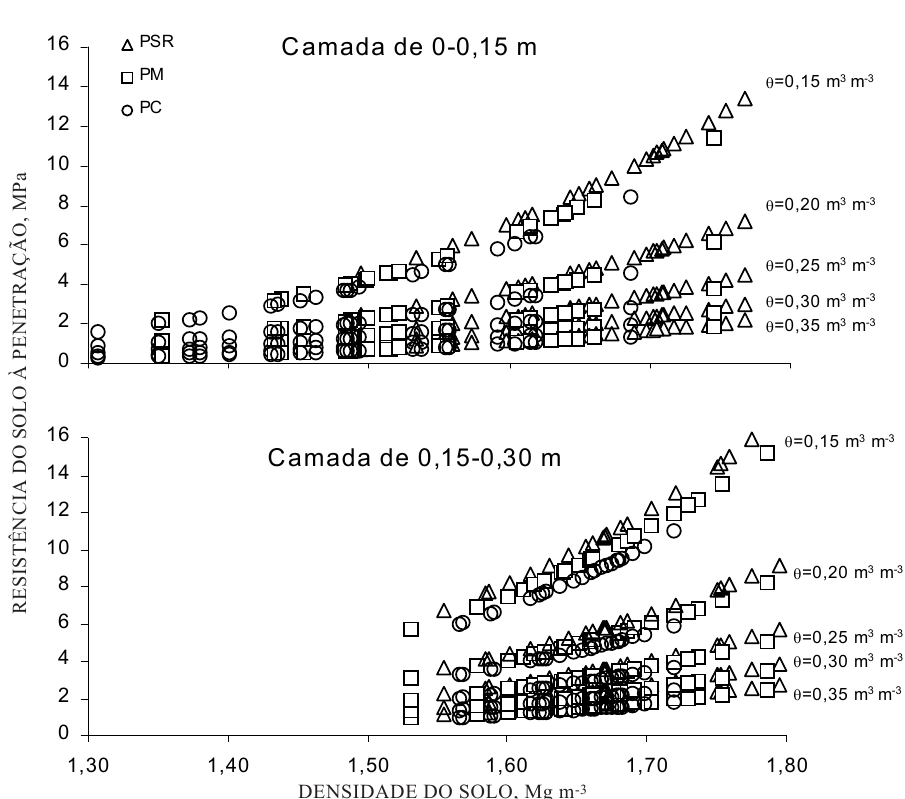
Figura 2. Resistência do solo à penetração (MPa) em função da densidade do solo, do teor de água do solo ( θθθθθ ) e do sistema de preparo e camadas amostradas. PSR = preparo sem revolvimento; PM = preparo mínimo; PC = preparo